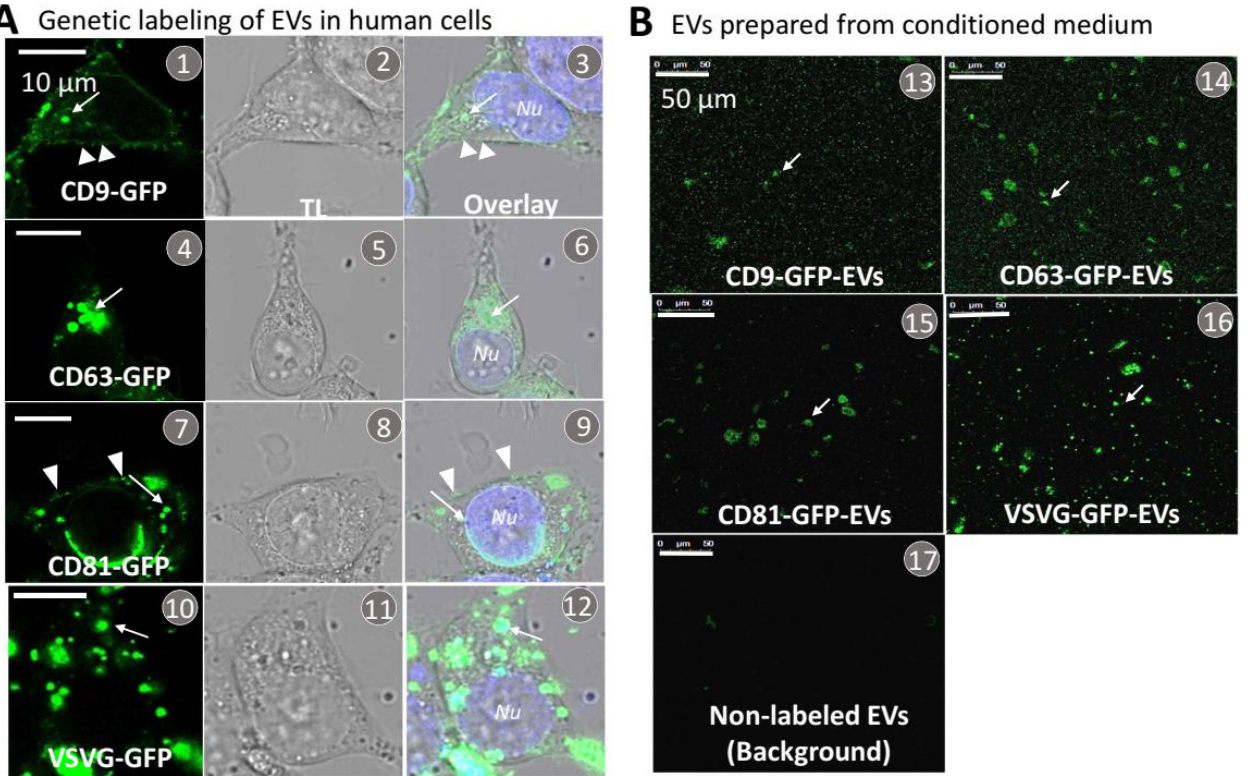
Figure 2. Transfection, expression, and isolation of genetically labeled EVs from conditioned medium of cultured 293T cells. ( A ) Cultured human 293T cells were transfected with each of the transmembrane scaffolds tagged with a GFP reporter, including CD9-GFP ( A1 – A3 ), CD63-GFP ( A4 – A6 ), CD81-GFP ( A7 – A9 ), and VSVG-GFP ( A10 – A12 ). At 48 h following the transfection, both fluorescence and transmitted light images were recorded. Arrows ( → ) indicate the incorporation of GFP-tagged scaffolds into the endocytic compartment of the endosome and/or MVB, while arrowheads (>) indicate focal incorporation into the plasma membrane. ( B ) EVs were prepared from the conditioned medium collected from the transfected cells, and confocal images were taken at the same dilution (0.1 µ g/ µ L, protein of EVs) for all samples ( B13 – B16 ). Images were also recorded using unlabeled control samples to quantify background noise ( B17 ). Arrows indicate individual/clustered EVs. Scale bar, 50 μm.